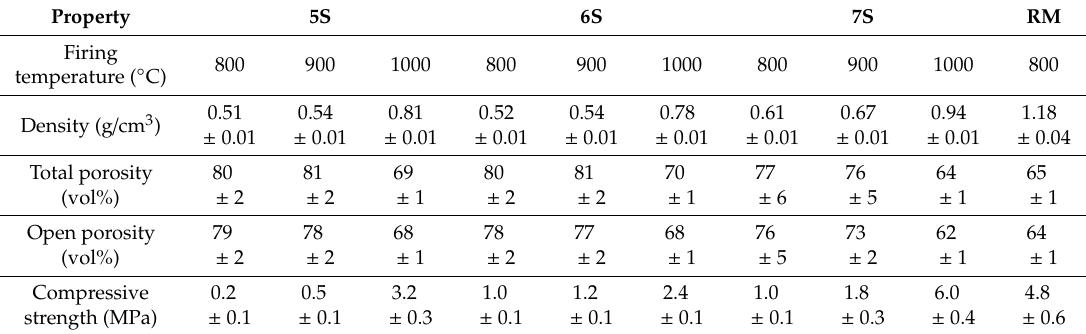
Figure 1. Optical stereomicroscope images of fly ash/glass-derived foams in the ‘green’ state ( a ): 5S; ( b ): 7S and after firing at 800 °C ( c ): 5S; ( d ): 7S. Table 2. Physical and Mechanical Properties of the Developed Cellular Glass-Ceramics (5S, 6S, and 7S: fly ash-derived materials; RM: red mud-derived material).